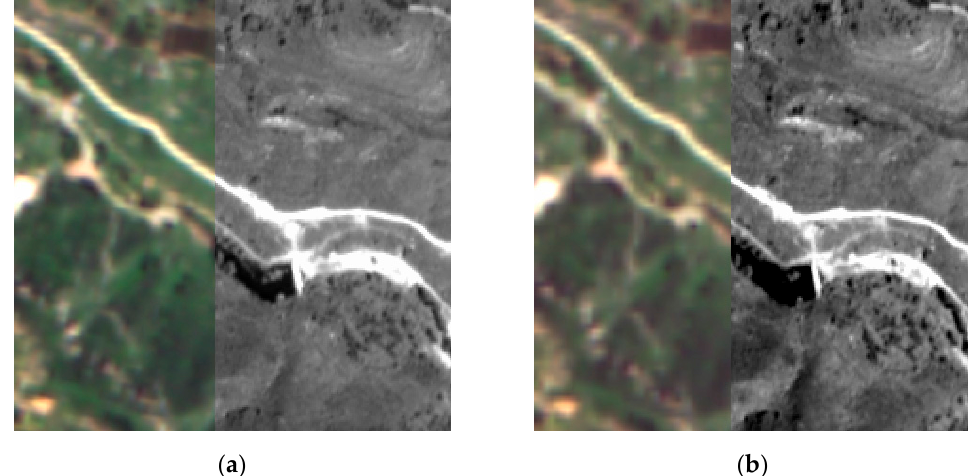
Figure 10. Comparison of the ZY3-02 registered image created using the method in this paper and the Level 2 PAN and MS up-sampled image. ( a ) PAN and MS images registered using the algorithm in this paper; ( b ) Level 2 PAN and MS up-sampled image.